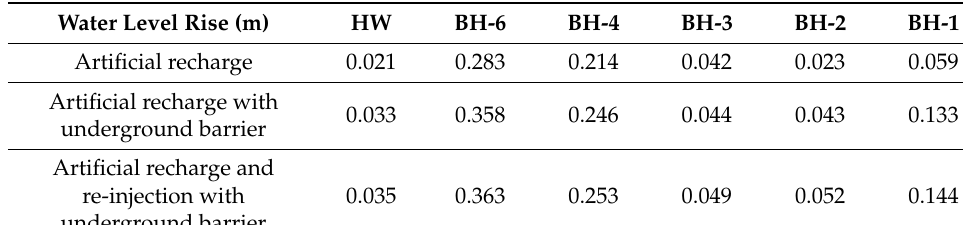
Table 2. Prediction of groundwater level rise due to artificial recharge and underground barrier by using a numerical model.